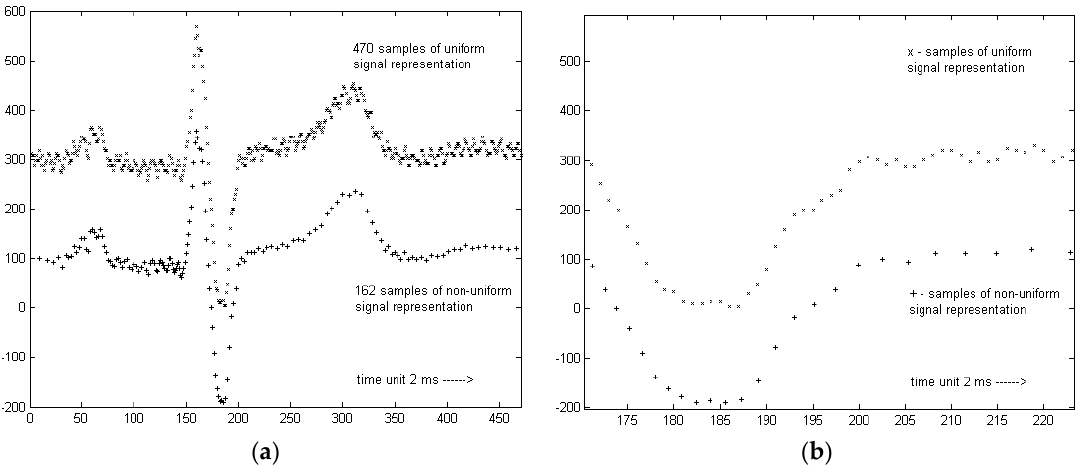
Figure 5. Regular and irregular representations of the same heartbeat ( a ) global scale, ( b ) local scale (terminal section of QRS). Vertical axes represent the ECG voltage, approximately 2.44 μ V per unit.